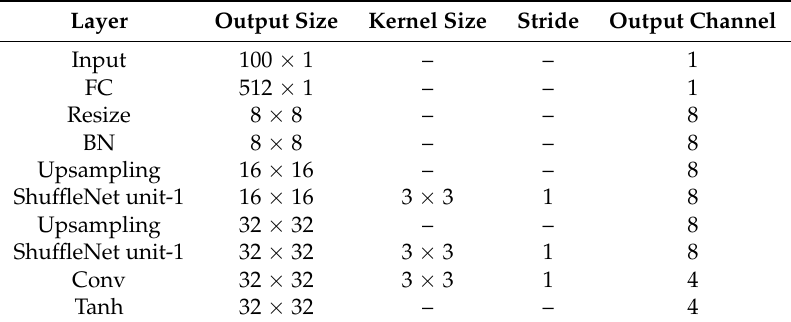
Table 1. Detailed architecture of the generator G in ShuffleGAN.